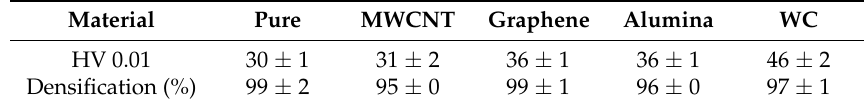
Table 5. Microhardness and densification of Al mixed with 1 vol. % of the nano/ultrafine reinforcements by means of the assisted sonication method, pressed (152 MPa) and sintered.